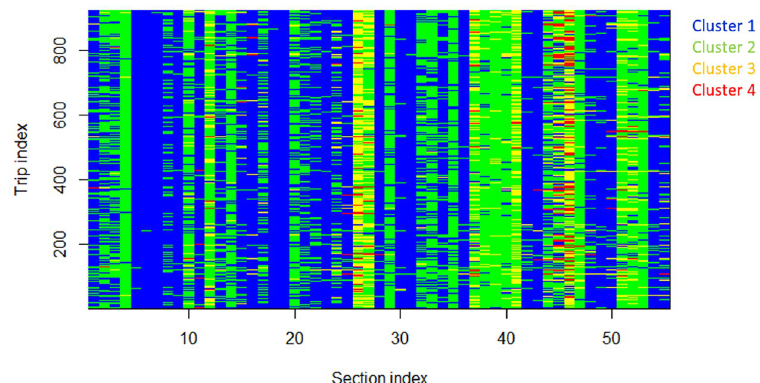
Fig 5. Cluster memberships for the x th iteration.